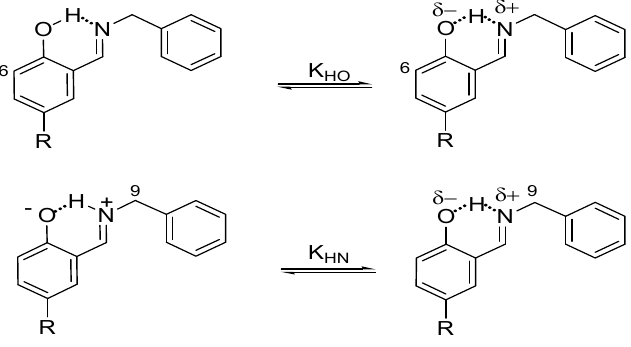
Figure 4. Linearization of 1 H chemical shifts from the δ -diagram for compounds 2 , 3 and 4 by Perrin model. ( δ slope of the straight line. Compounds 2 (Cl) y = 1.031(±0.002) x + 8*10 − 5 , R =